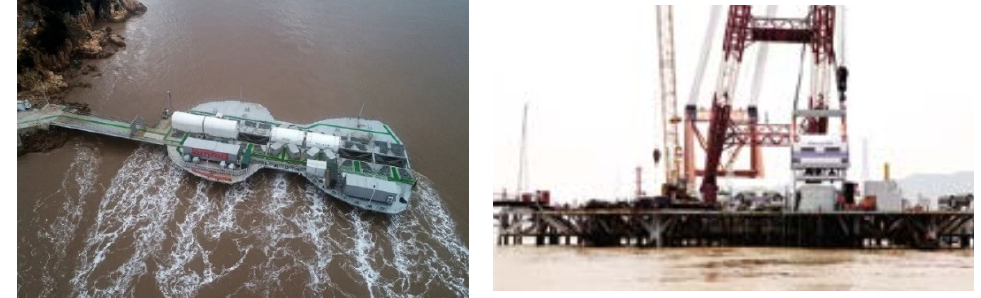
Figure 30. LHD 1 MW power generation module. Reproduced from [79,80].